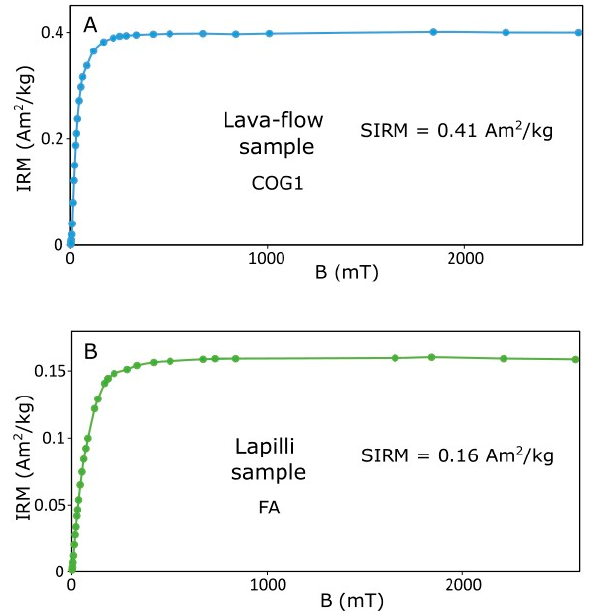
Figure 6. Progressive IRM acquisition curves for representative samples. ( A ) COG1 (lava-flow); ( B ) FA (lapilli). Table 4. Results of model fitting for seven selected samples from lava flows and lapilli using the MAX UnMix software [37]. B 1/2 : median acquisition field; DP: dispersion parameter; S: parameter- describing skewness; EC: relative extrapolated contribution of each component to the total measured magnetization; IRM: isothermal remanent magnetization of each component. Units: B 1/2 in mT; IRM in 10 − 3 Am 2 /kg; DP, S, and EC are dimensionless.